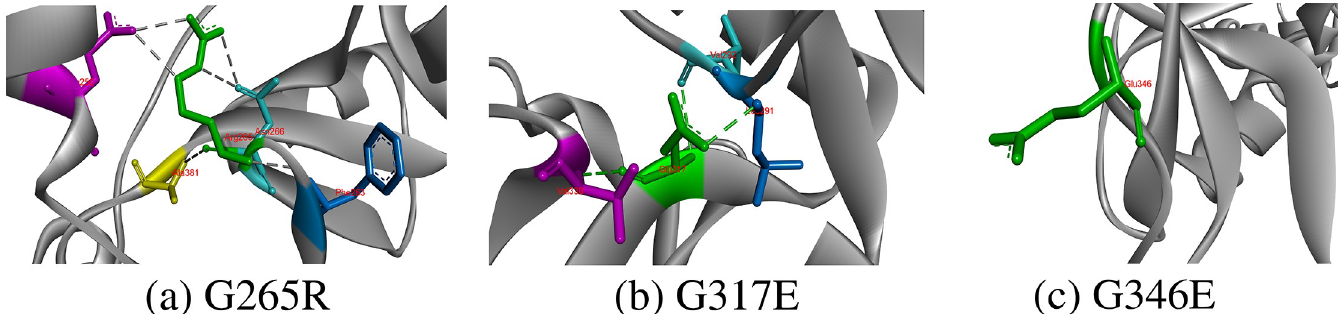
Fig 5. Replacement of Glycine at 265, 317 and 346 positions with respective residues and their hydrophobic and hydrogen bonds interactions.